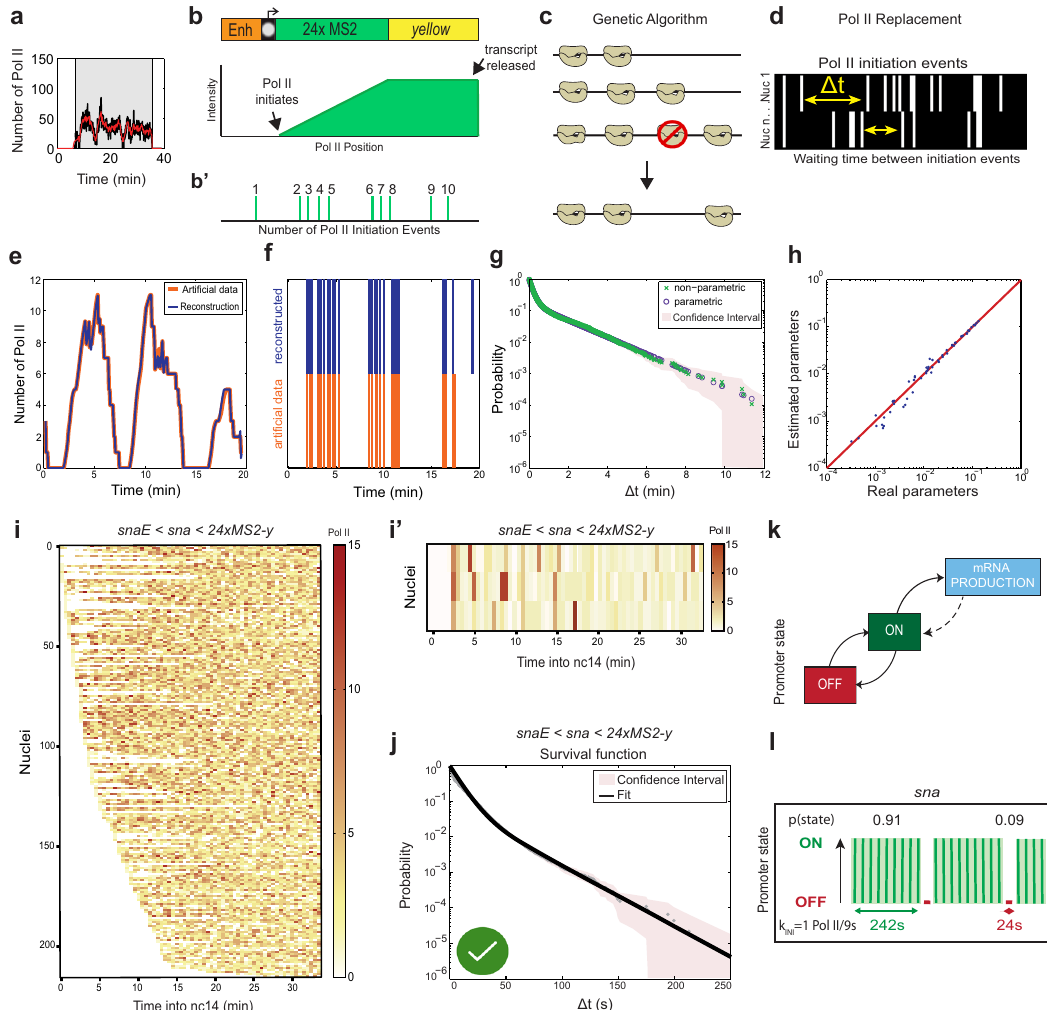
Fig. 2 From live imaging of transcription to positions of initiation events, a machine-learning procedure. a Representative trace of a single-nucleus transcriptional activity. The gray box indicates the analyzed transcriptional window, the black curve represents the signal expressed as the number of polymerases, and the red curve the reconstructed signal after the deconvolution procedure. b Fluorescence intensity at the transcription site is a function of the passage of a single polymerase as well as the number of polymerase initiation events. c A genetic algorithm is used to decompose fl uorescence intensities and optimally locate polymerases within the gene body. d For each nucleus, the position of polymerases is used to extract Δ t, the lag time between two successive initiation events. e Simulated representative trace (orange) and the number of polymerases after deconvolution (blue). f Known positions of polymerases (orange) and reconstructed polymerase positioning after deconvolution. g Nonparametric (green) and parametric (blue) survival function estimate for simulated data estimated using the Kaplan – Meyer method. The shaded region indicates 95% con fi dence interval estimated based on Greenwood ’ s formula. h Comparison of known parameters used to generate arti fi cial data (real parameter) with parameters obtained by applying our analysis pipeline (estimated parameters). Red line indicates perfect concordance. i Heatmap showing the number of polymerases for the 216 snaE < sna nuclei as a function of time. Each row represents one nucleus, and the number of Pol II initiation events per 30 s bin is indicated by the bin color. j A representative population from i. k Survival function of the distribution of waiting times between polymerase initiation events (red circles) and the two- exponential fi tting of the population estimated using the Kaplan – Meyer method (black line). The shaded region indicates 95% con fi dence interval estimated based on Greenwood ’ s formula (see Supplementary Table 1). A green check indicates accepted fi tting. l A two-state model showing the probabilities to be in either the permissive ON state or the inactive OFF state for the snaE < sna transgene. m Representation of estimated bursting dynamics for the snaE < sna transgene. Permissive ON state durations are depicted in green and inactive OFF states in red, and probabilities of each state shown above (see also Supplementary Table 2). Statistics: snaE < sna , 216 nuclei, 3 movies; see Supplementary Movie